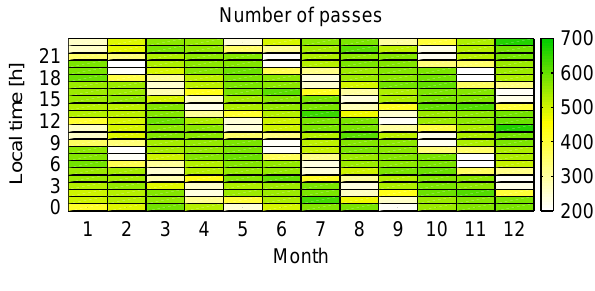
Fig. 1. Number of passes used in the statistical analysis for each month/local time hour